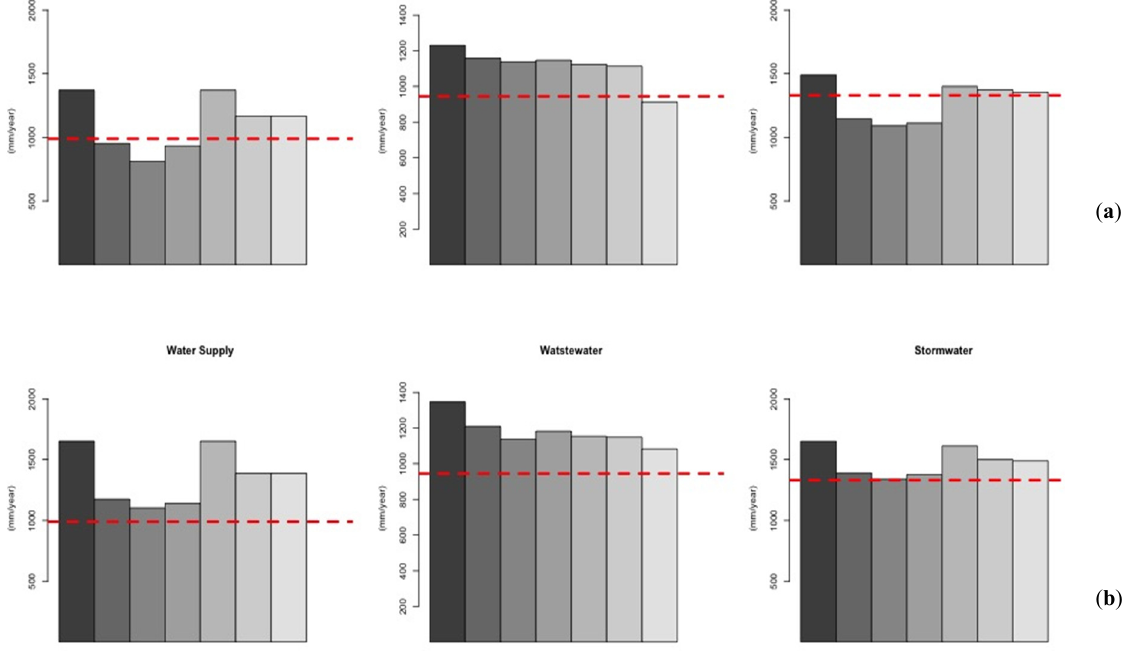
Figure 5. ( a ) Flow of Drinking Water, Wastewater, and Stormwater for the 10-year period and ( b ) Flow of Drinking Water, Wastewater, and Stormwater for the 20-year future cases in Tunjuelo Catchment.